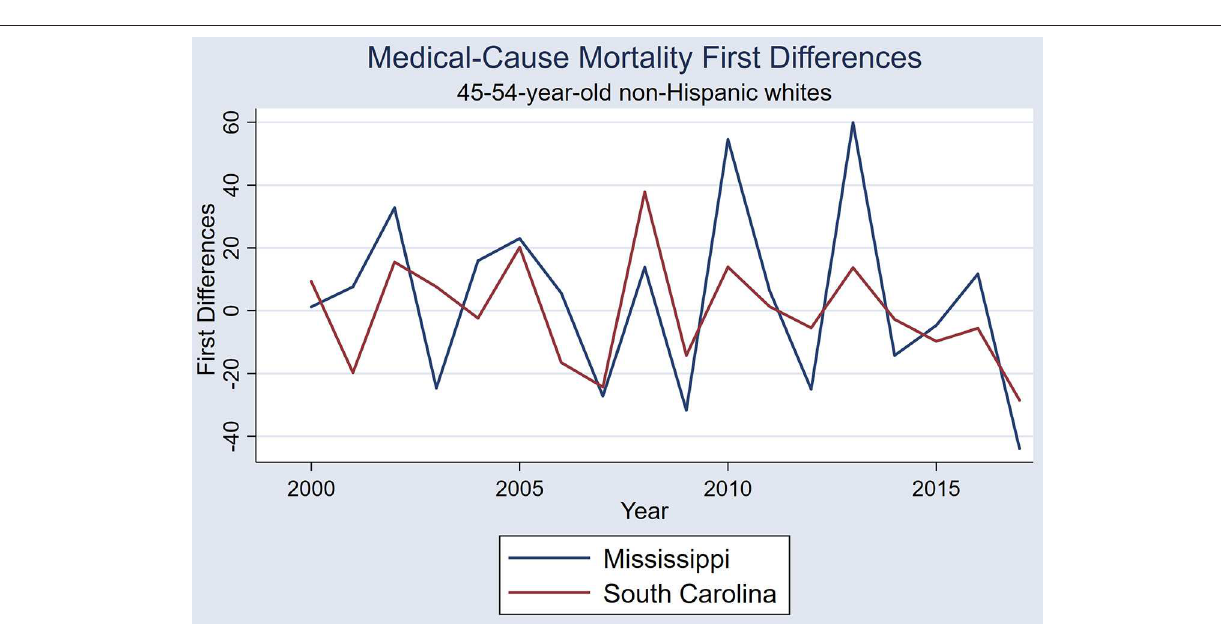
FIGURE 3 | First differences of annual medical-cause mortality rates in Mississippi and South Carolina (Spearman rank coefficient 0.701, P =